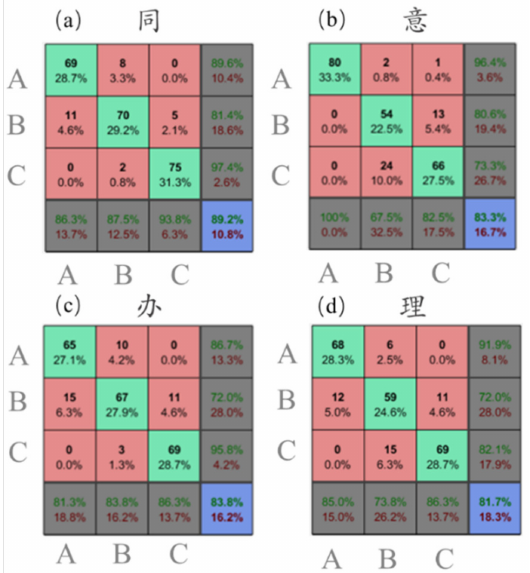
Figure 12. The results of a neural network test in which four subjects wrote the Chinese characters